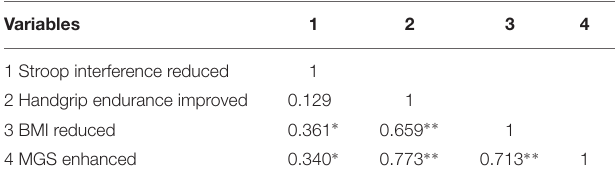
TABLE 4 | Bivariate-correlation-matrix difference scores for Stroop interference, handgrip endurance, BMI, and MGS. Variables